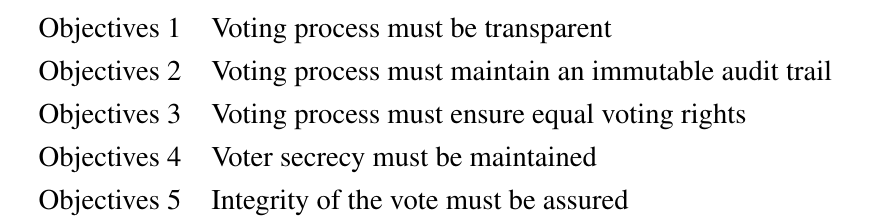
Table 2. Architecture